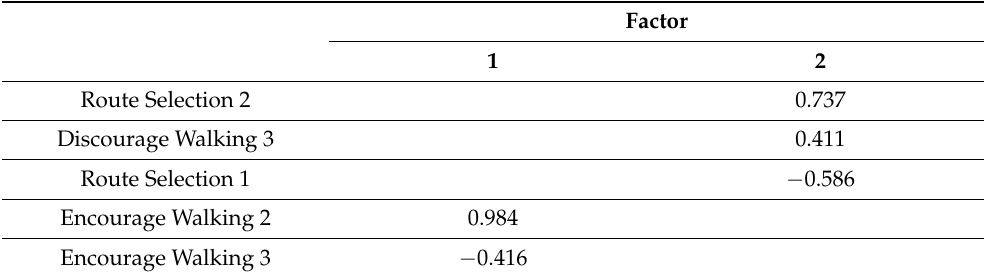
Table 2. Latent Factors Obtained and their Relationship with the Observed